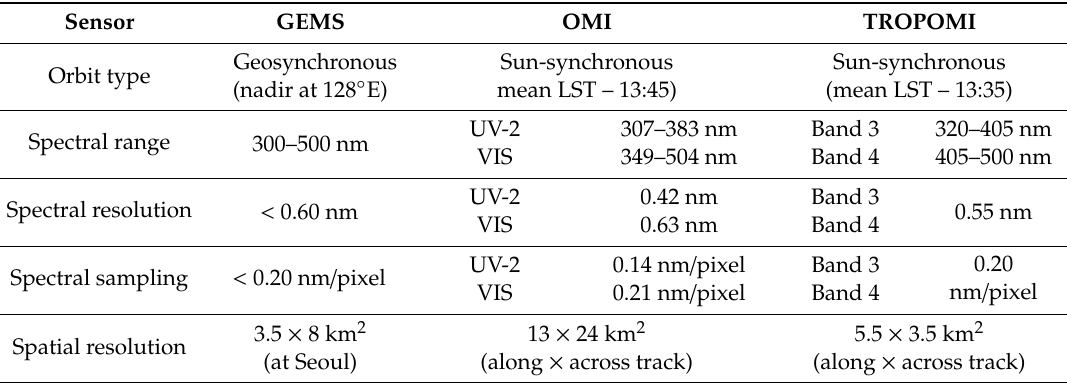
Table 1. Sensor specifications for the GEMS, OMI, and TROPOMI.